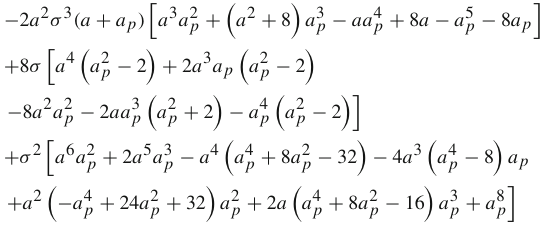
(cid:8) (cid:2) (cid:5) a 3 a 2 p + a 2 + 8 a 3 p − aa 4 p + 8 a − a 5 p − 8 a p